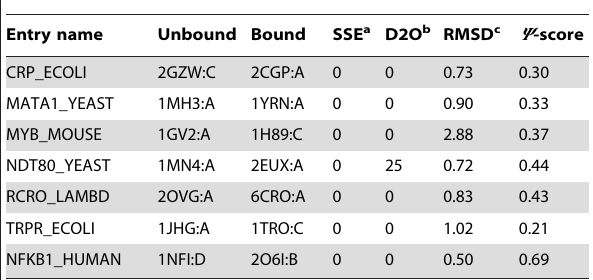
Table 6. Structural transitions upon DNA-binding.